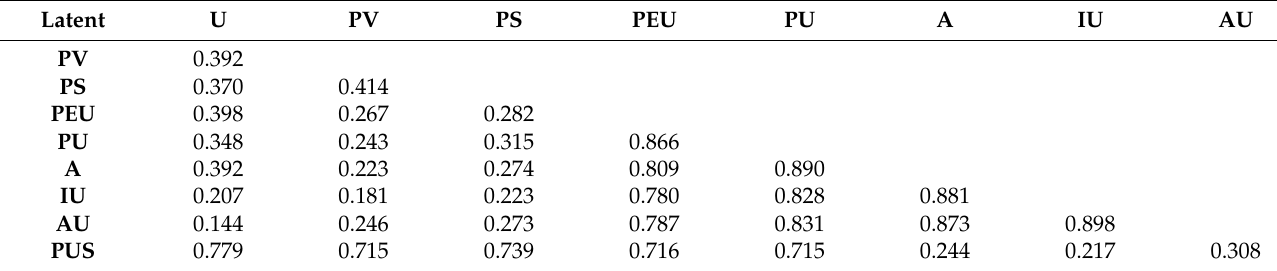
Table 6. Pearson’s R